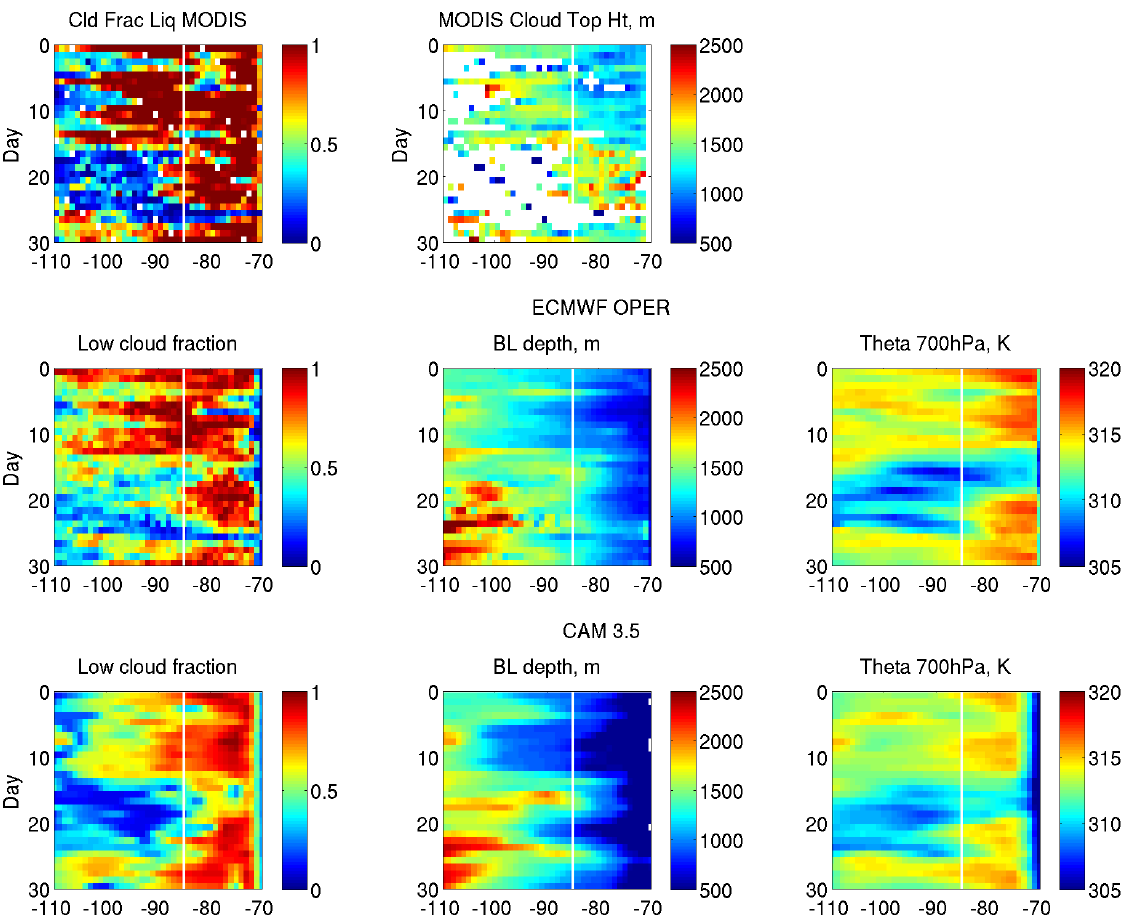
Fig. 14. Hovm¨uller diagrams of 24-h means along 20 ◦ S for October 2006. MODIS cloud fraction and cloud top height (m) are plotted in the top row. The bottom two rows are low cloud fraction, boundary layer depth (m), and potential temperature at 700hPa (K) for the ECMWF operational model and CAM 3.5, respectively. The white line indicates the stratus buoy position. All data are horizontally averaged over a 1 ◦ × 1 ◦ box.